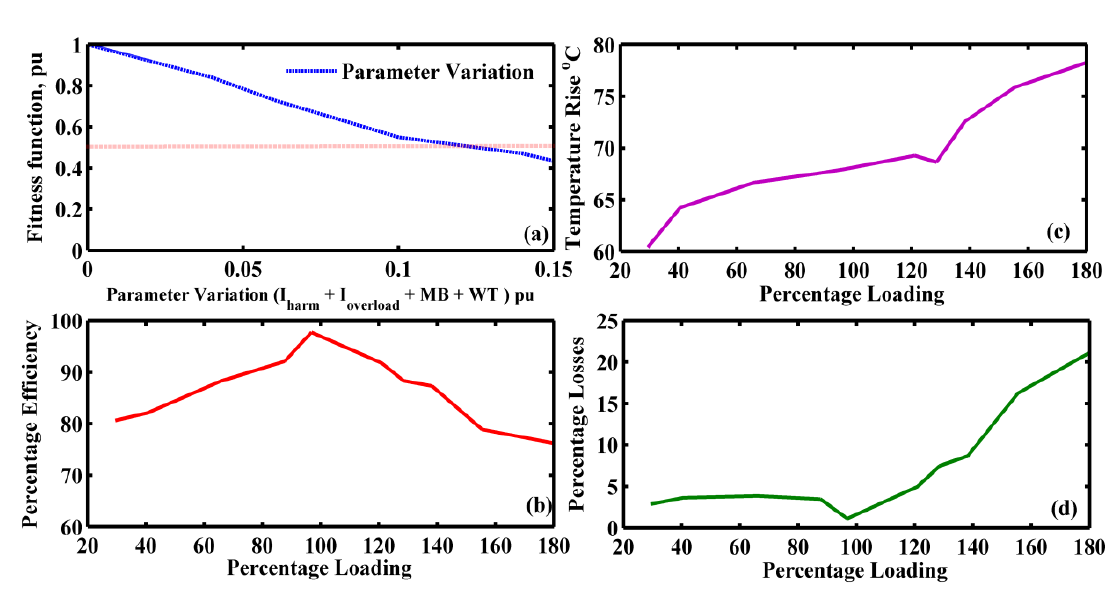
Fig. 11. (a) Parameter variation v/s fitness function, (b) Loading v/s efficiency, (c) Loading v/s temperature and (d) Loading v/s losses.